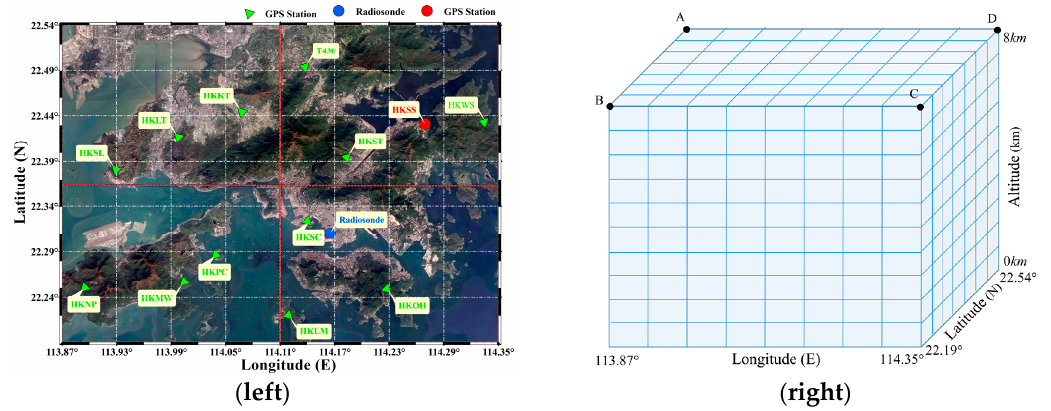
Figure 2. Geographic distribution of GNSS, radiosonde station ( left ) and 3-D tomographic voxels ( right ). Table 1. Information of stations and boundary points.